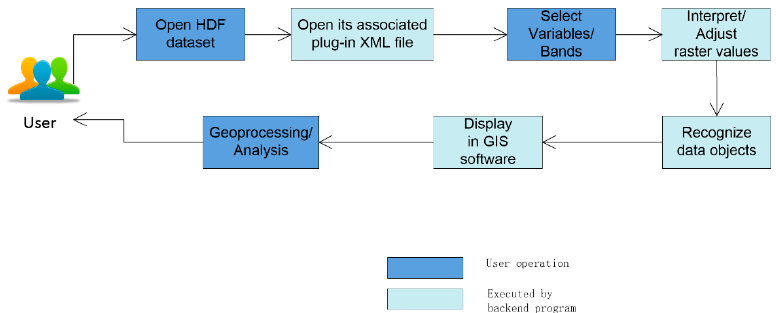
Figure 8. EO data Processing workflow using Geographic Information Systems (GIS) and the plug-in framework.